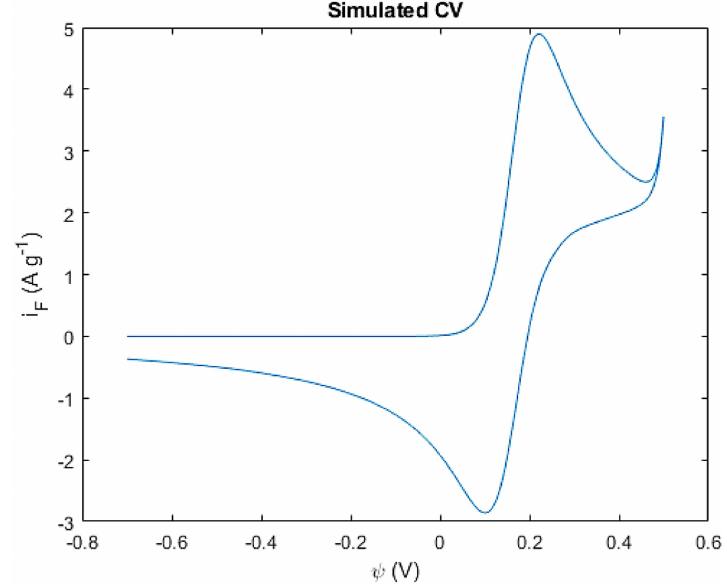
Figure 5. 1. Figure 9. Simulated CV with the presence of